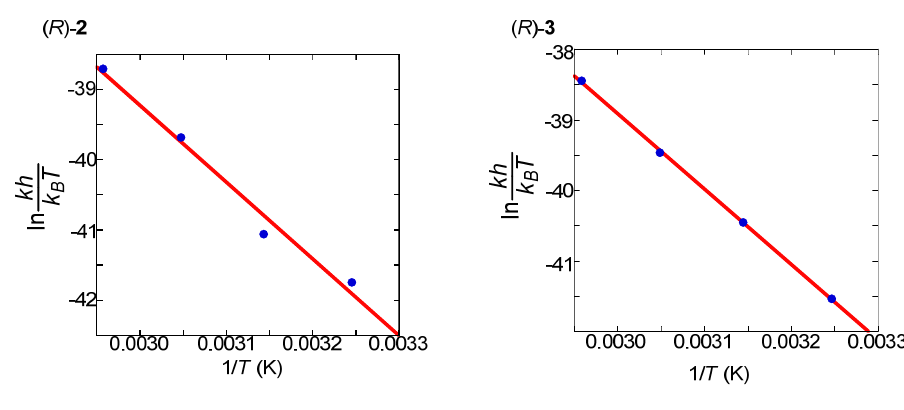
Figure 9. Eyring plots for cis to trans thermal isomerization of ( R )- 2 - 8